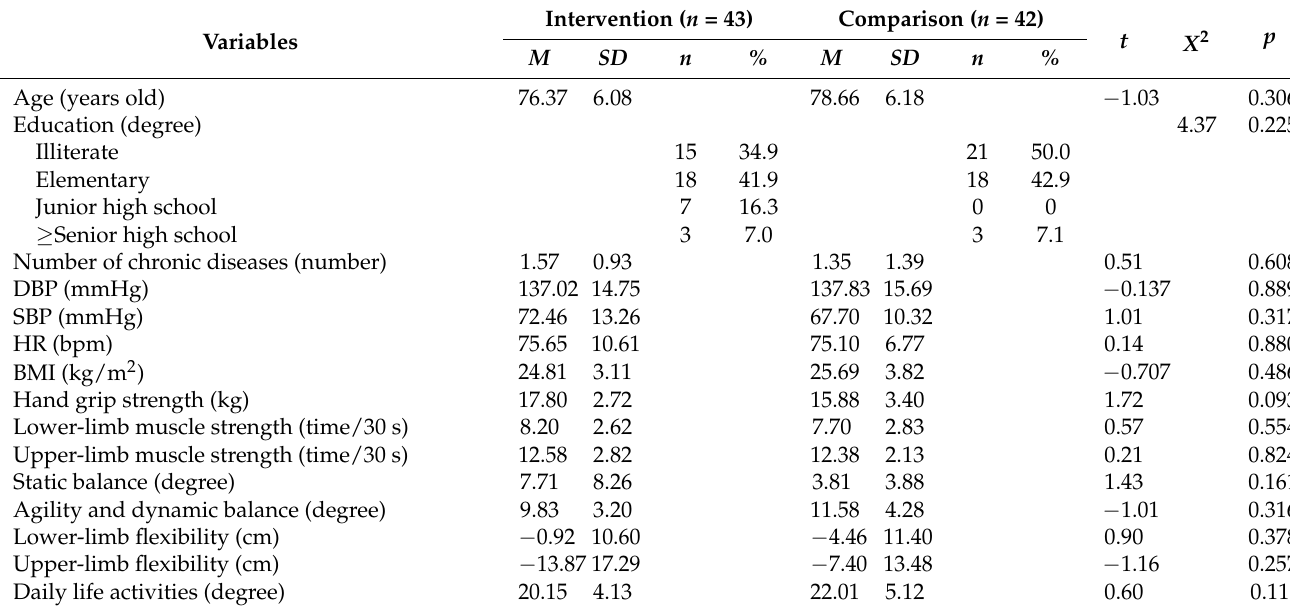
Table 2. Demographic characteristics of study participants in the intervention and comparison groups at baseline.